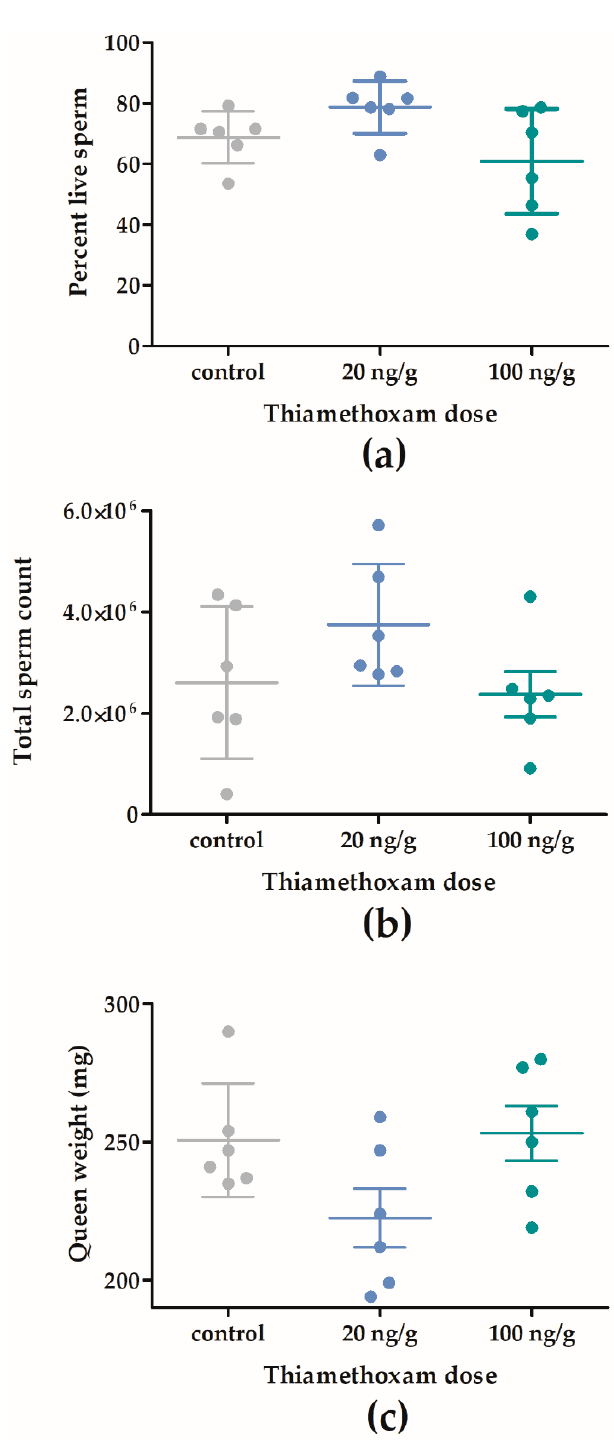
Figure 6. Chronic overwinter thiamethoxam (20 and 100 ng / g) exposure does not impact Apis mellifera queen quality. Honey bee colonies were exposed to thiamethoxam (THI) during winter 2017–2018 in field trial 1, and queens were sacrificed in August 2018, for determination of percent sperm viability ( a ), total sperm counts ( b ), and queen weight ( c ). Plots indicate mean ± SD.